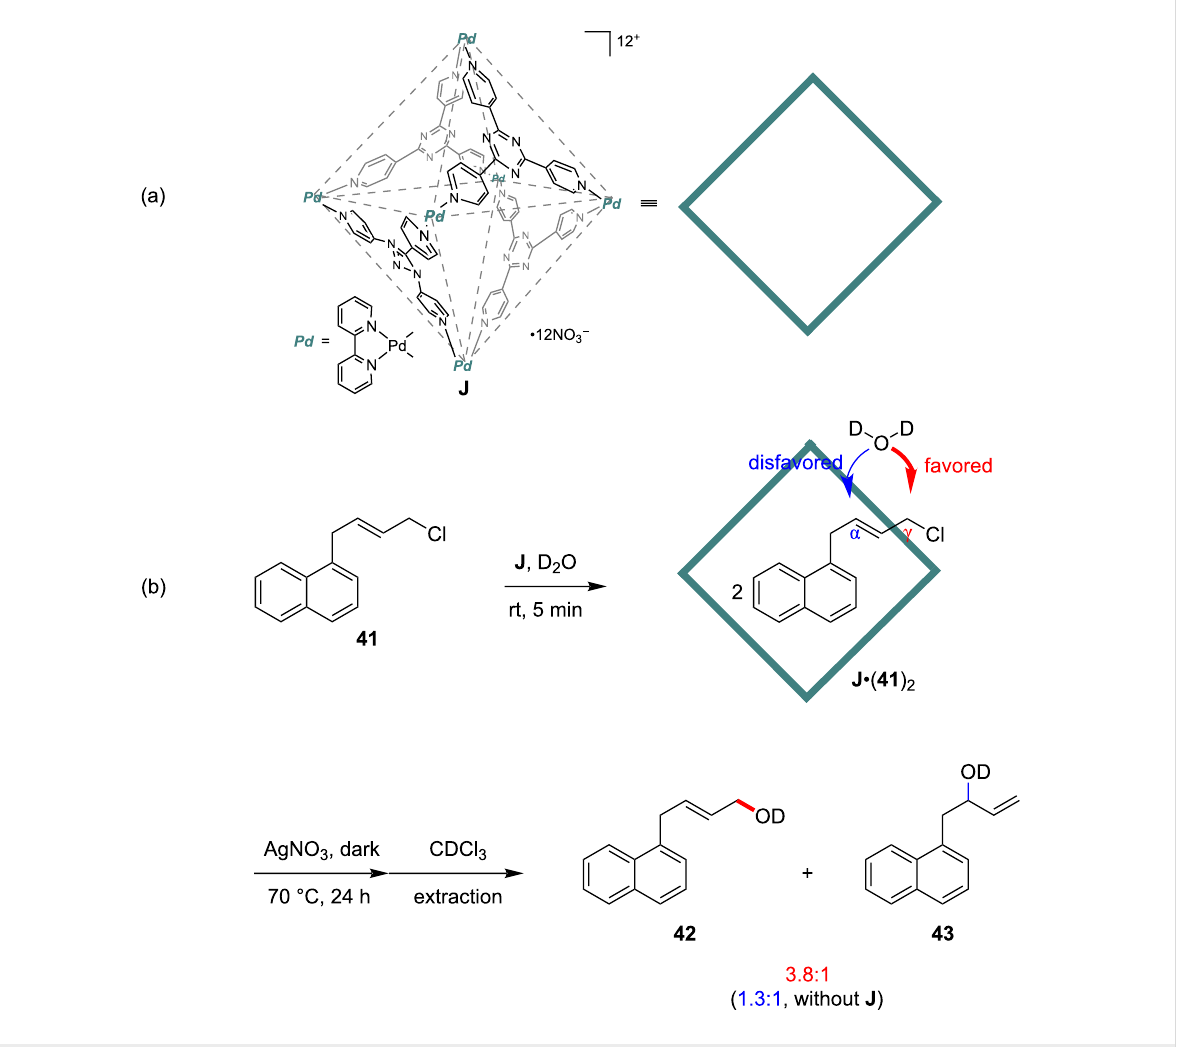
Figure 12: Site-selective nucleophilic substitution reaction of allylic chlorides mediated by cage host J